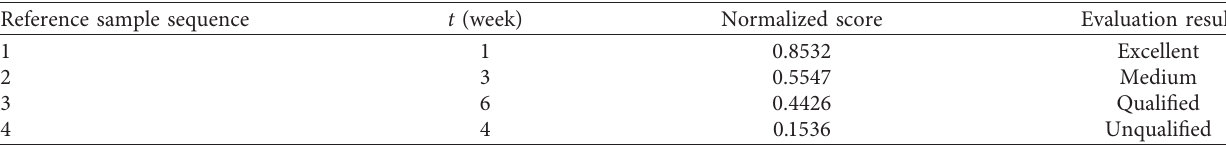
Figure 6: Comparison of evaluation results and target values. Table 4: Evaluation results of typical